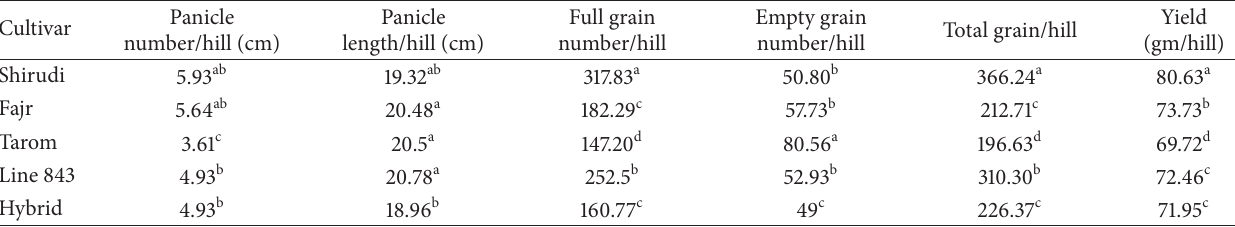
Table 2: Effect of cultivar on yield and yield components across